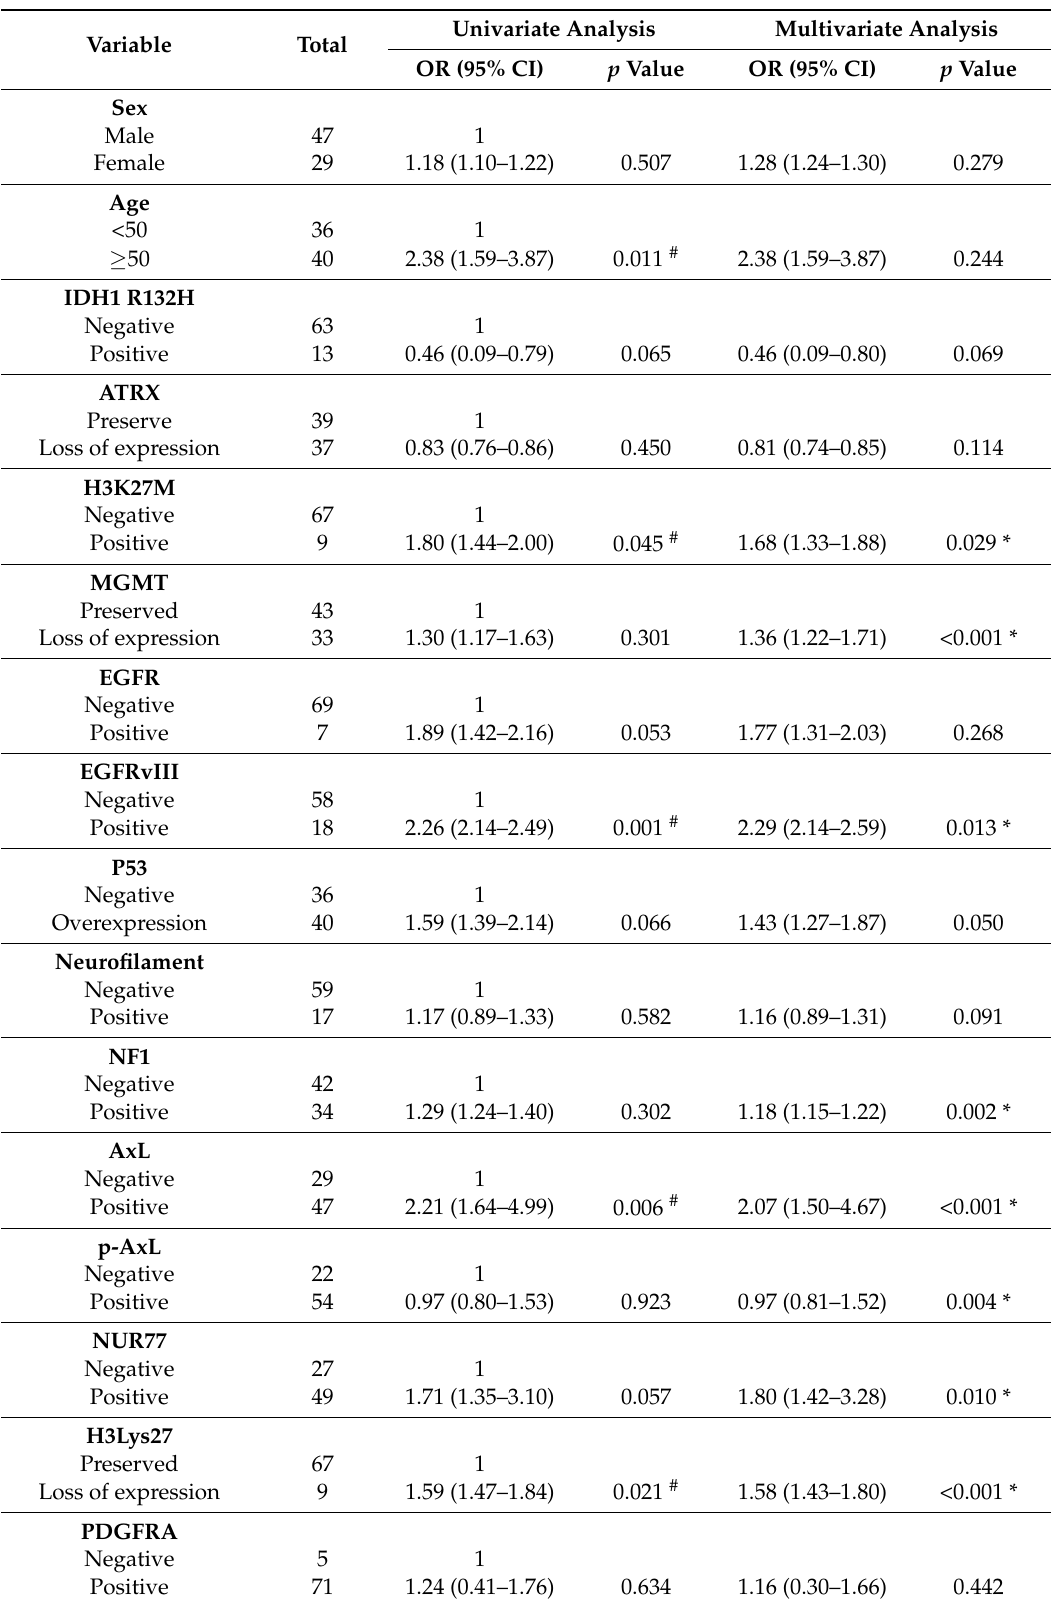
Table 2. Univariate and multivariate analysis of risk factors associated with PLP2 expression. Univariate Analysis Multivariate Variable Total